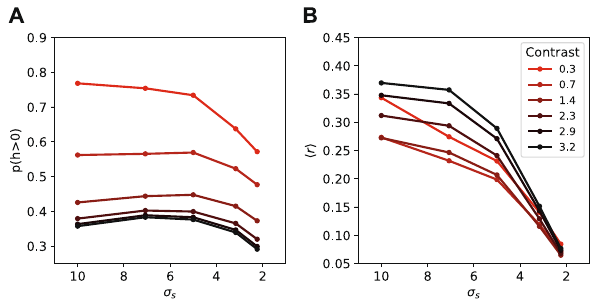
Figure 10. Neural activity changes due to prior uncertainty. (A) Number of neurons with non-zero activity in response to stimuli from different prior distributions. Fewer neurons fired when the prior distribution was more narrow. (B) The average activity of the population decreased with a more narrow prior probability distribution. While higher contrast led to increased neural activity. For the lowest contrast value the activity in the network also rises again.